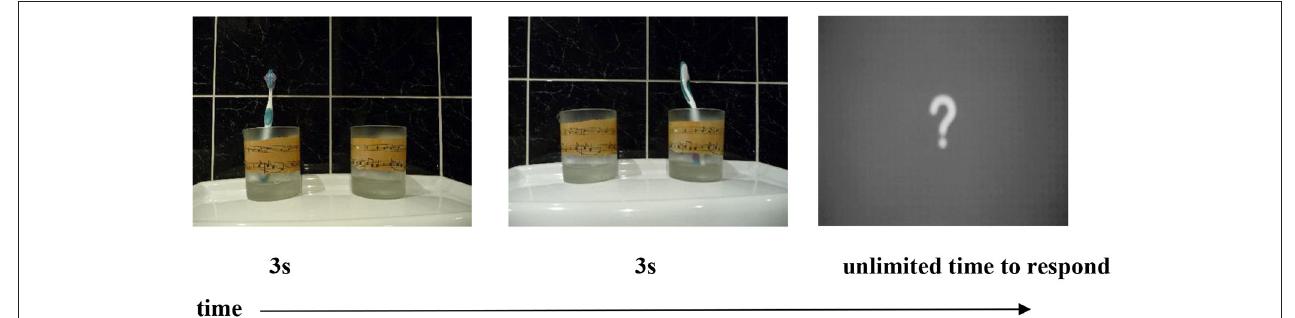
FIGURE 3 | Example of a locative trial with a change in both orientation and